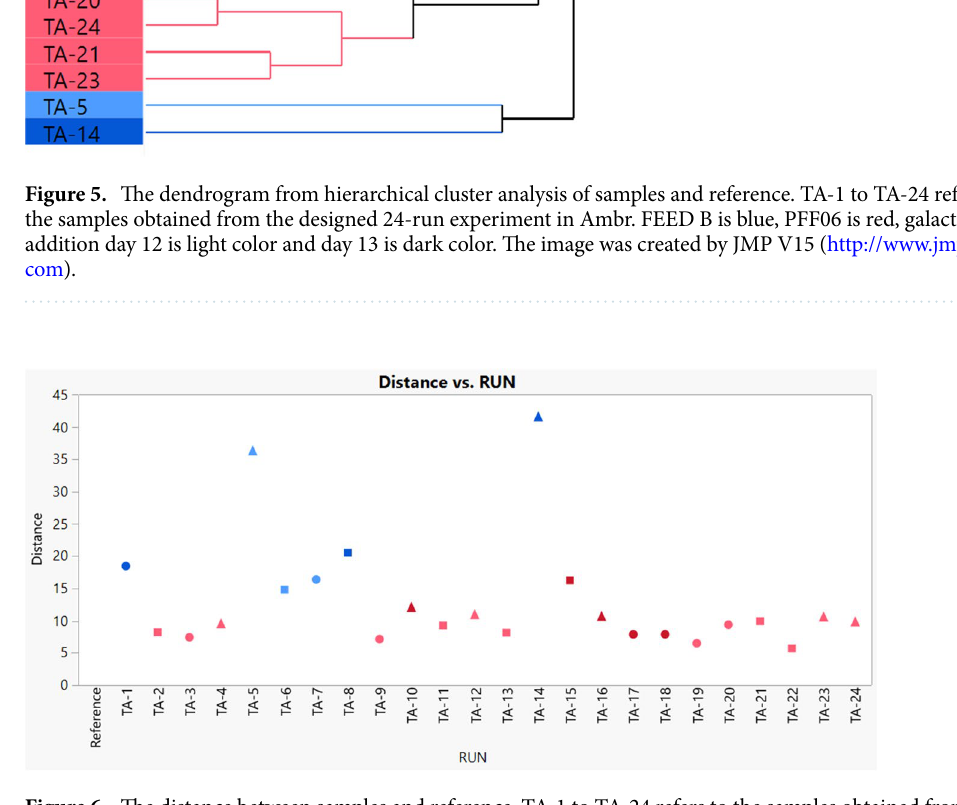
Table 2. Among the four factors, base medium and feed medium had the most significant impact on similarity. On the graph of effect evaluation for factors (see Fig. 7), it is clear that the effect of CD14 and CD15 was almost the same and they were more appropriate for achieving biosimilarity for the antibody than Dynamis. For the feed medium, PFF06 can attain an antibody with more similar glycan profile to the reference compared to that with the Feed B. Consequently, the optimal medium composition was CD14 and PFF06. Considering the pro-